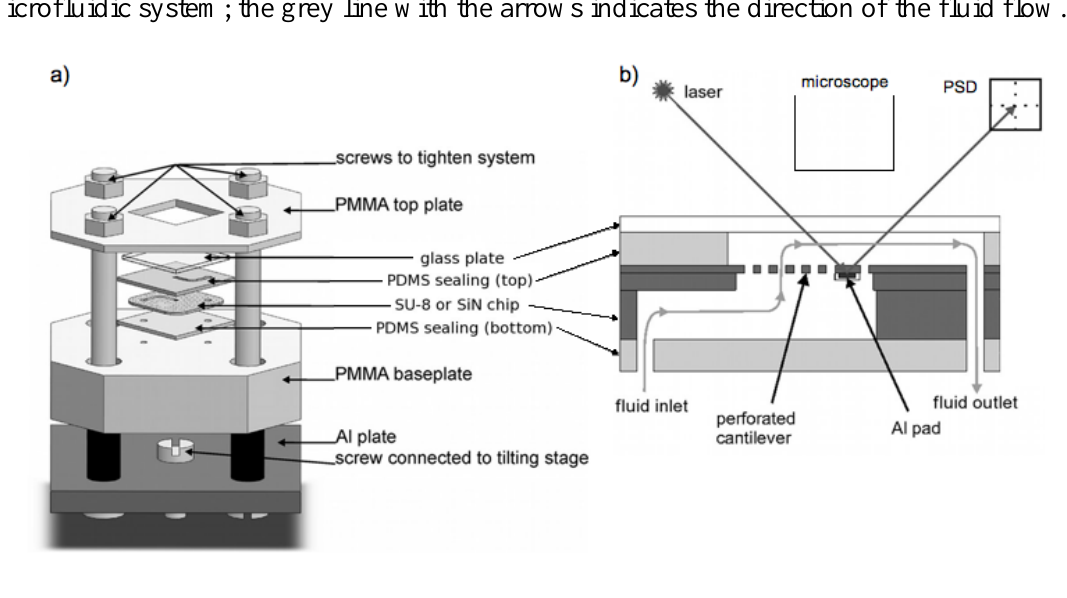
Figure 6. Schematics of the mechanical holder with the microfluidic system and the SU-8 or SiN chip: ( a ) Three-dimensional view of the mechanical holder. ( b ) Side view of the microfluidic system; the grey line with the arrows indicates the direction of the fluid